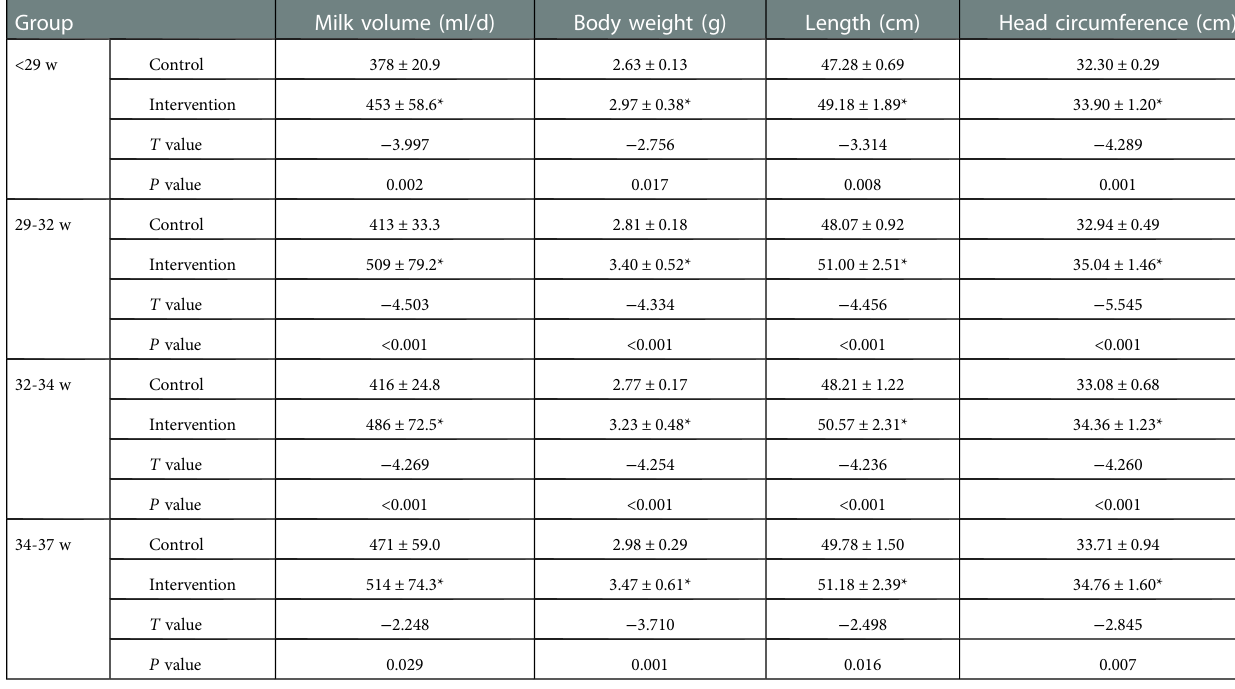
TABLE 3 Comparison of physical development of preterm infants with different gestational ages at 40 weeks corrected age. Group Milk volume (ml/d) Body weight (g)